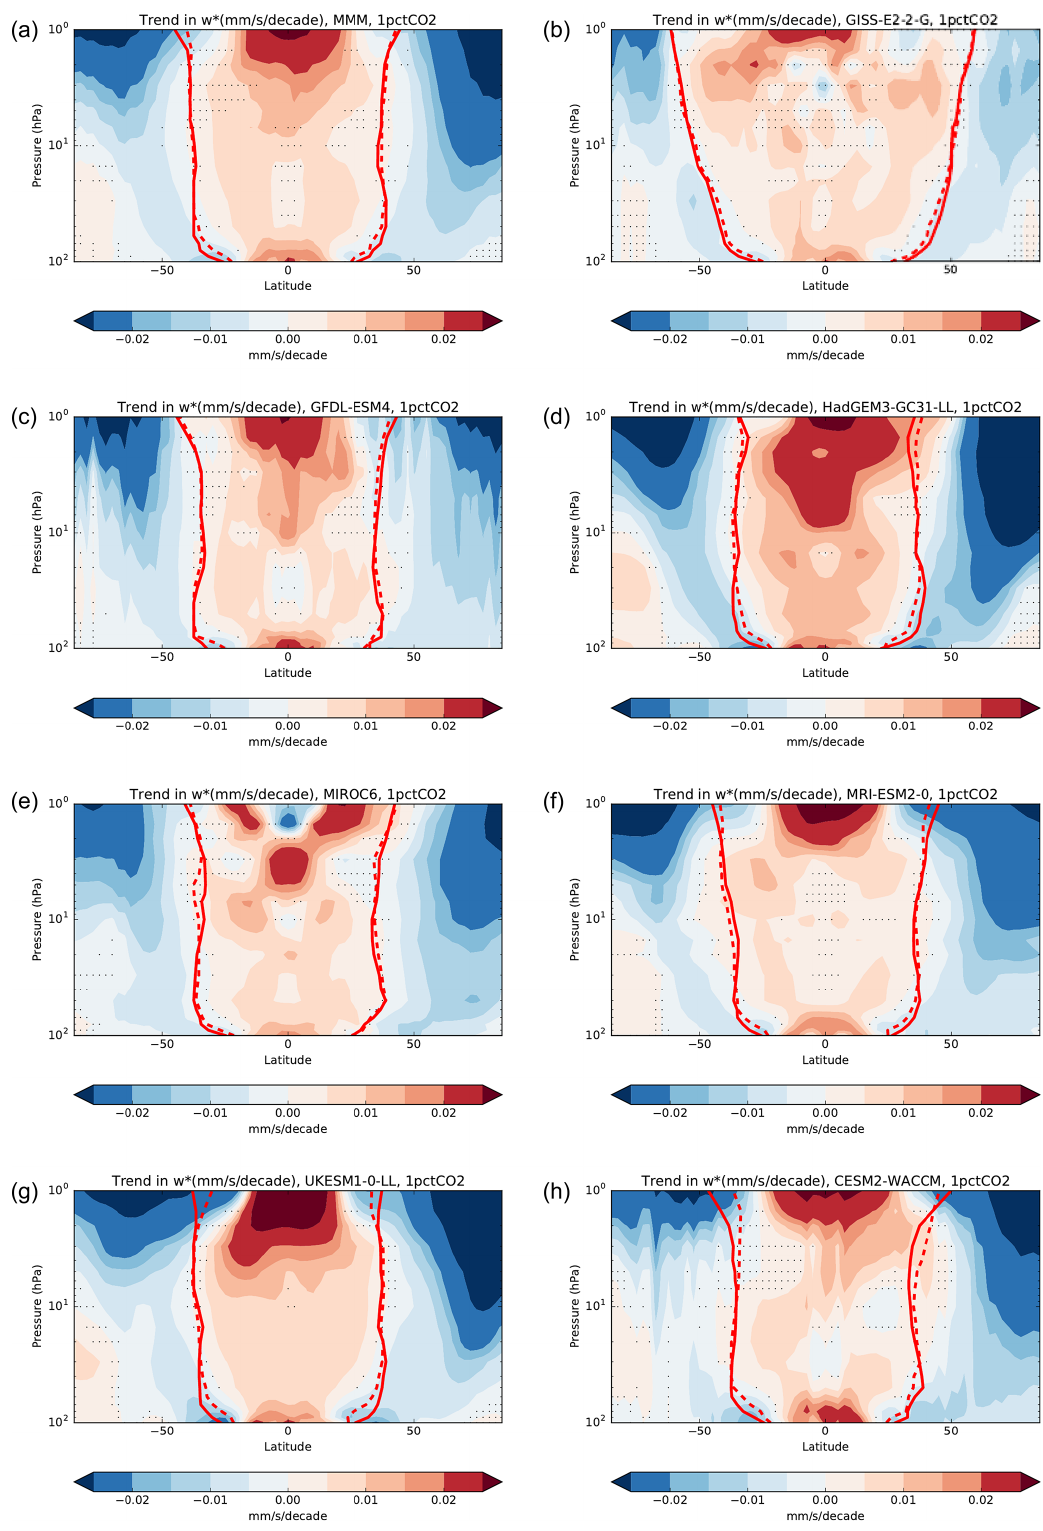
Figure 8. Trend in w ∗ (mms − 1 per decade), computed using 150-year time series from 1pctCO2 experiments. Panel (a) shows multimodel mean (MMM). Panels (b) to (h) show individual models. Turn around latitudes show regions of upwelling in the first 20 years (solid red lines) and last 20 years (dashed red lines) of these 150-year simulations. Stippling in (a) denotes regions where it is not the case that the trend is significant in at least 66% of models. Stippling in (b) to (h) denotes regions where the trend in that model is not